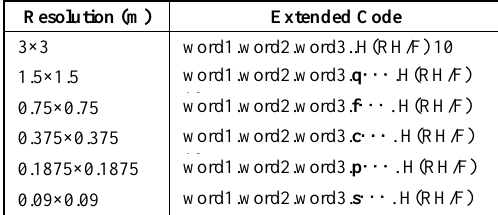
Table 1. Extended five-word code of w3w According to the resolution, the maximum residual offset of the geocoded location from the centroid of the cell is ranging from 1.06 meter to 0.06 meter. The w3w extensions provide higher precisions by simply adding one more word to the original three- word code. This coding schema retains the advantage of w3w as being easier to remember (Barr, 2015). While the MapCode provides precisions ranging from 5 meters to 0.16 meter by increasing the code from 5 digits to 8 digits with mixing numbers, letters, and symbols (Geelen, 2015). Similarly, Google’s Open Location Code uses a 10-digit code to represent a square of 14- meter by 14-meter in size, which defines the precision to be roughly 10 meters. To increase the precision, the code needs to be lengthened (Open Locaiton Code,